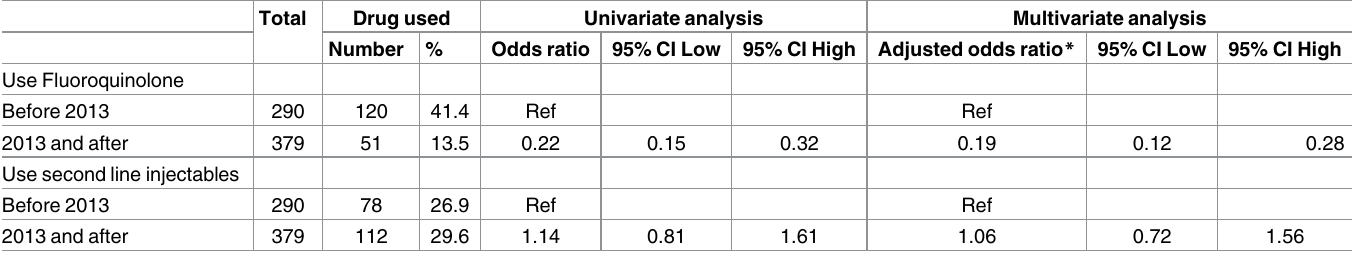
Table 5. Changes in the prescribing of fluoroquinolone and second line injectable agents before and after 2013 in Tuberculosis Treatment Center, Yunnan Center of DiseaseControl, Yunnan, China.